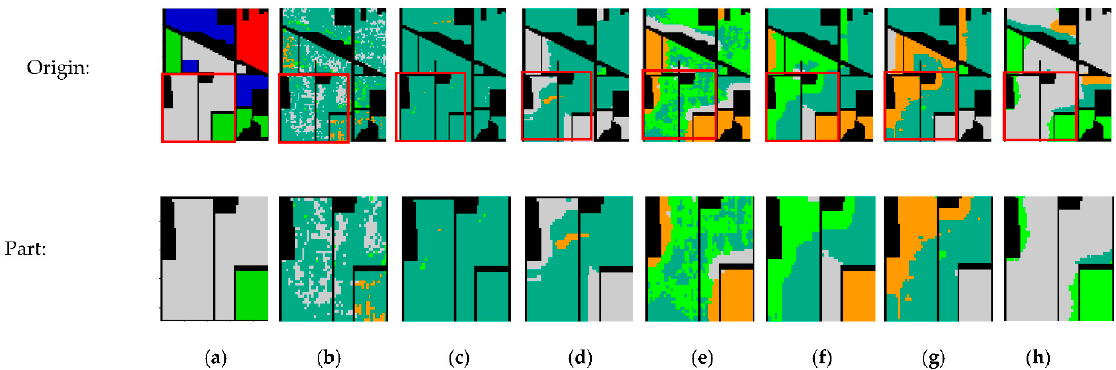
Figure 15. Clustering results obtained using different methods on the Indian Pines corrected data set with Gaussian noise and salt and pepper noise. ( a ) Ground truth. ( b ) LRSC 41.08%. ( c ) SSC 43.86%. ( d ) S4C 51.33%. ( e ) EDSC 52.24%. ( f ) EGCSC 54.68%. ( g ) EKGCSC 52.49%. ( h ) SSAKGCSC 64.50%.